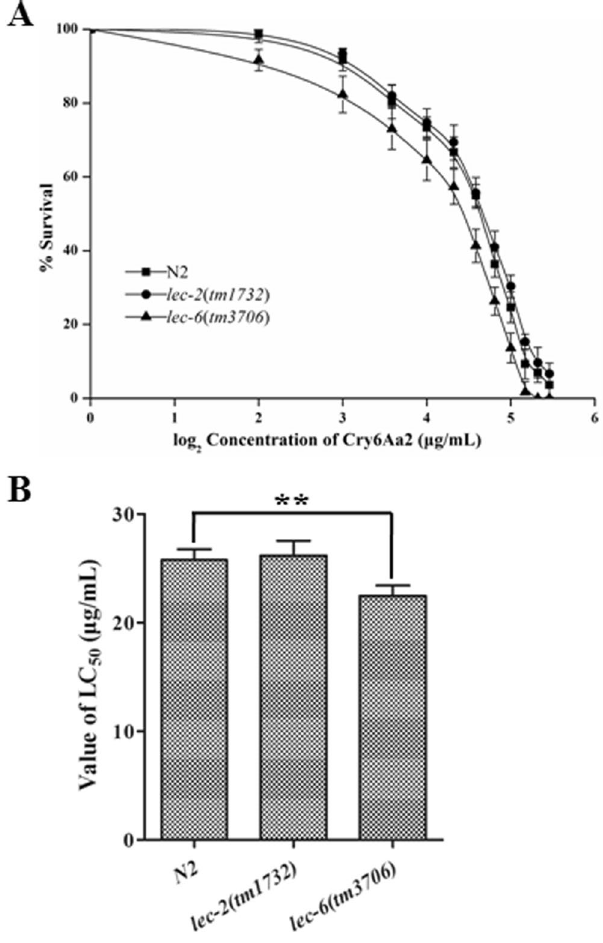
Figure 6. Hypersensitivity comparison of C . elegans mutants related to galectin to Cry6Aa2 toxin. ( A ) Dose- dependent mortality assays of Cry6Aa2 against mutants. The percentages of alive worms as a function of Cry6Aa2 concentration were plotted using nonlinear regression. Each point represents the mean and standard deviation from three independent experiments with five replicates. ( B ) Comparison of the LC 50 values of Cry6Aa2 against N2 worms and mutants. Data were showed as mean ± SD. Two asterisks indicate P <